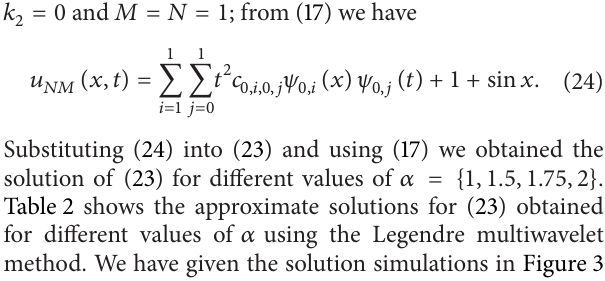
Example 4. Consider the fractional nonlinear Klein-Gordon equation